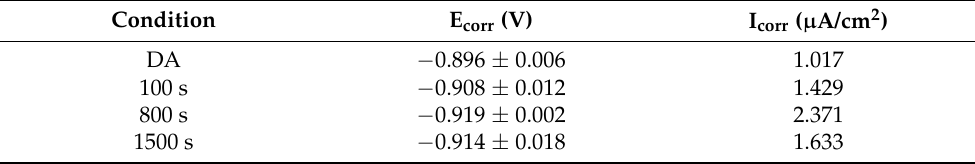
Figure 5. Polarization curves of the alloy under DA and isothermal treatment: ( a ) polarization curves; ( b ) enlarged details. Table 3. Polarization curve parameters of DA and different isothermal time samples.